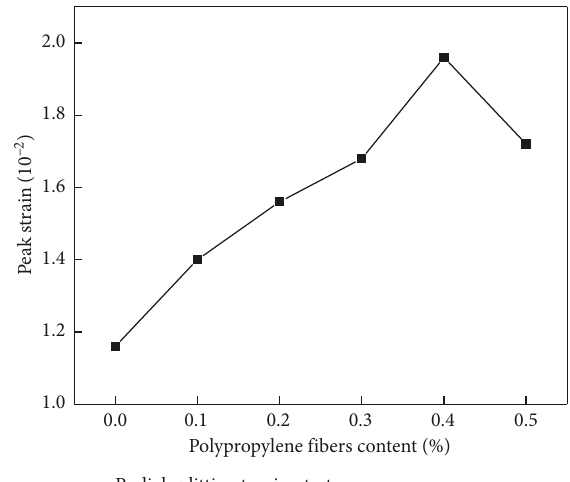
Figure 11: Peak strain diagram of soil-cement reinforced with different polypropylene fiber and 8% fly ash contents.